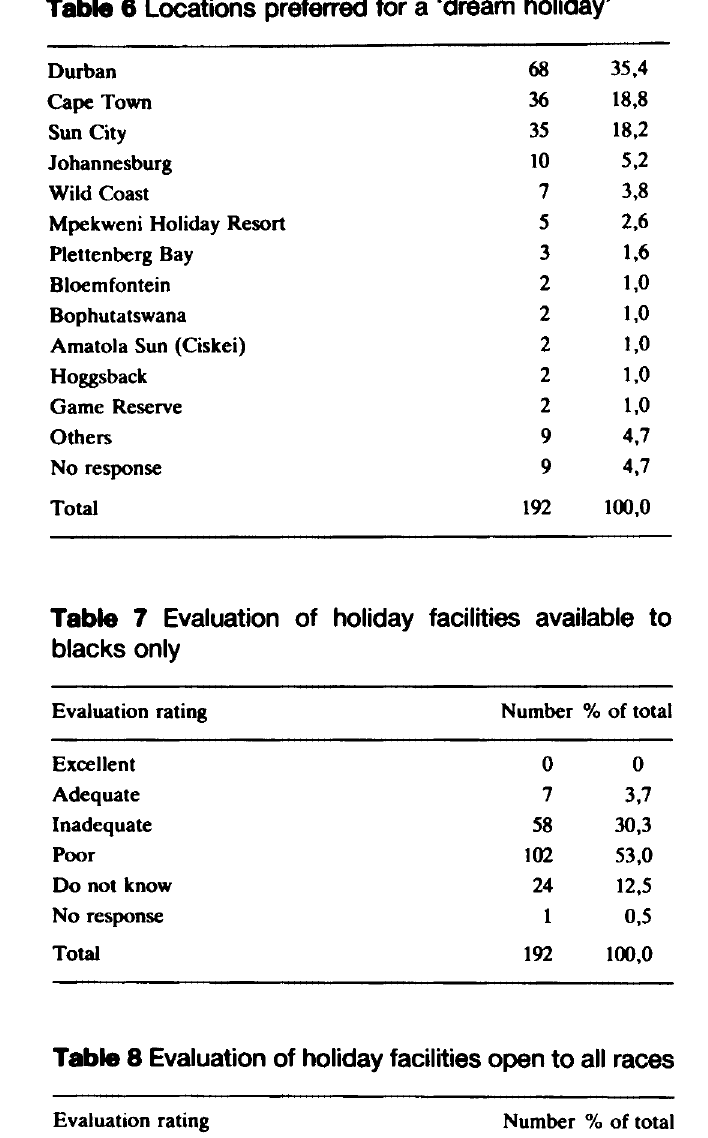
Table 8 Evaluation of holiday facilities open to all